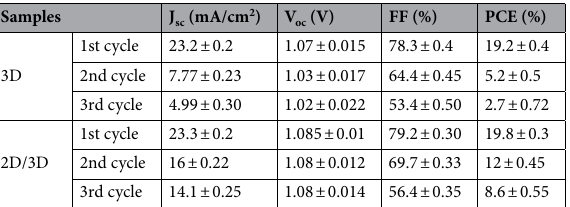
Table 1. Photovoltaic parameters of the 3D and 2D/3D samples extracted for the three cycles within the period of 5000 h with the difference of 2500